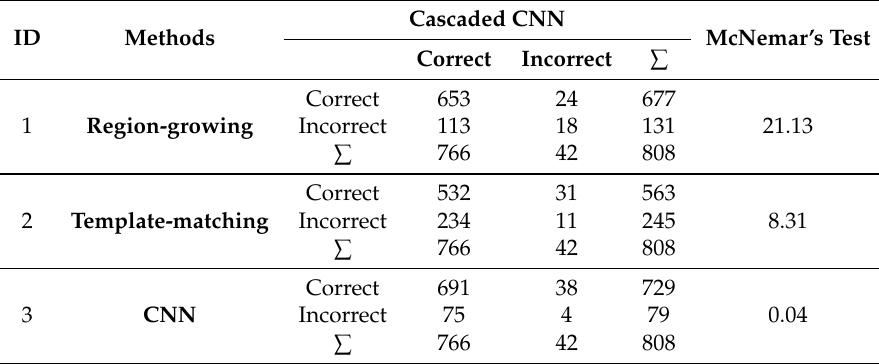
Table 5. The results of McNemar’s test in Test Area